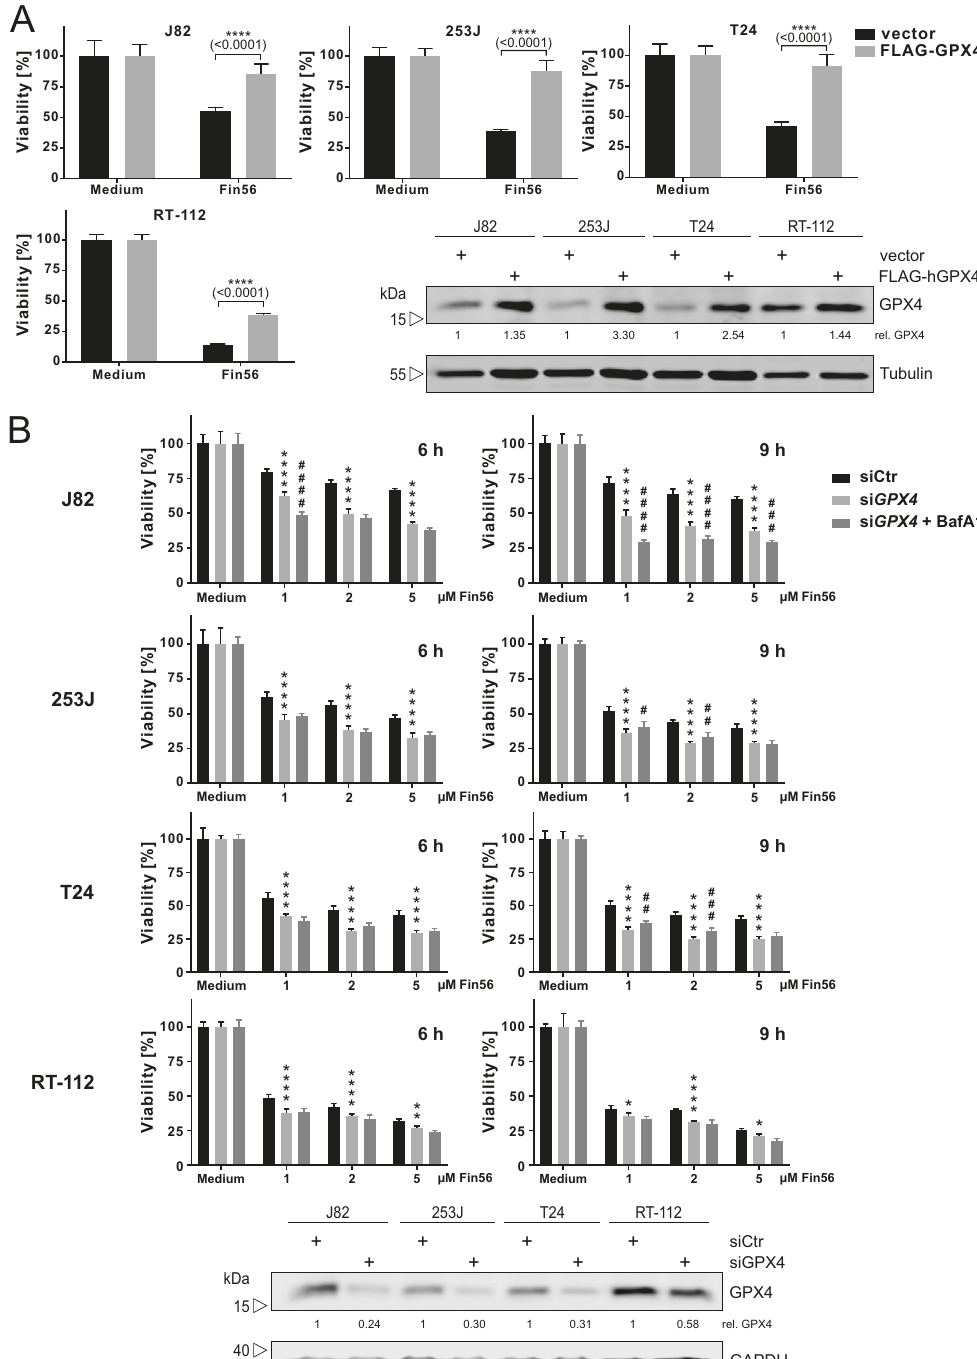
Fig. 7 GPX4 knockdown abolishes autophagy-dependency of Fin56-induced ferroptosis. A J82, 253J, T24, or RT-112 cells were transiently transfected with empty vector or cDNA encoding FLAG-hGPX4. After 30 h, cells were seeded into 96-well plates for MTT cell viability assay and into six-well plates for immunoblotting. For cell viability assay, cells were treated with 5 µM Fin56 for 9 h. Then, cell viability was measured using MTT assay. Results are shown as means + SD of two independent experiments performed in triplicates for each treatment. P values were determined by two-way ANOVA with Sidak ’ s post hoc test. Simultaneously, cells in six-well plates were lysed and cellular lysates were immunoblotted for GPX4 and tubulin. B J82, 253J, T24, or RT-112 cells were transfected with control or GPX4 siRNAs. After 48 h, cells were left untreated or treated with different concentrations of Fin56 (1 – 5 µM) with or without 20 nM ba fi lomycin A 1 for 6 or 9 h. After treatment, cell viability was measured using MTT assay. Results are shown as means + SD of two independent experiments performed in triplicates for each treatment. P values were determined by one-way ANOVA with Tukey ’ s post hoc test. The asterisk (*) represents the comparison between siCtr and si GPX4 , whereas the octothorpe (#) indicates the comparison between si GPX4 and si GPX4 + BafA1. Successful knockdown was con fi rmed by immunoblotting for GPX4 and